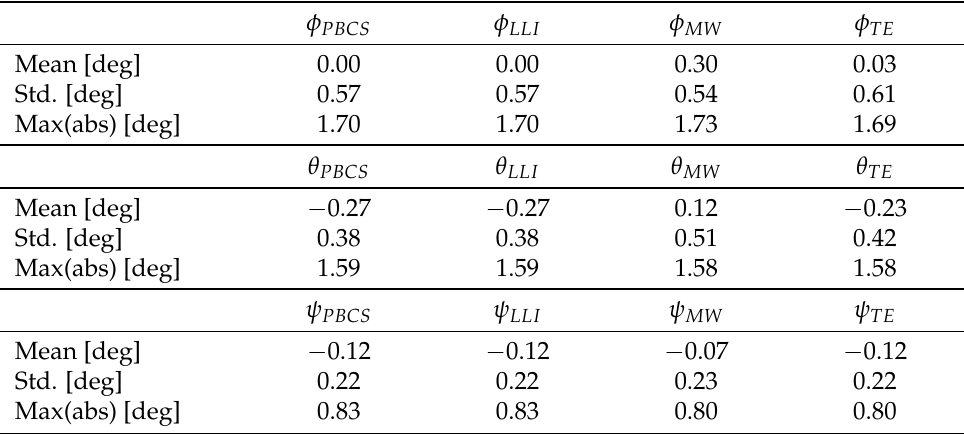
Figure 7. Attitude angles and differences from the reference—Case Study 1. The non-significant differences in statistical data of the attitude angle comparison (Table 5) confirm the high IAR ratios on the moving baselines and the accuracy of attitude estimation. Table 5. Attitude angle difference statistics from KVH unit—Case Study